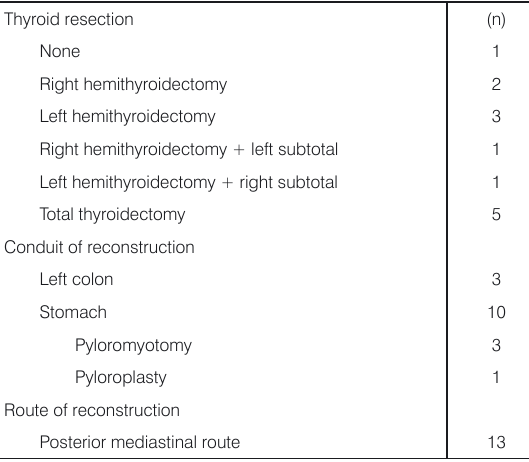
Figure 1. Overall and Disease Free survival curves in the postoperative period. (Kaplan